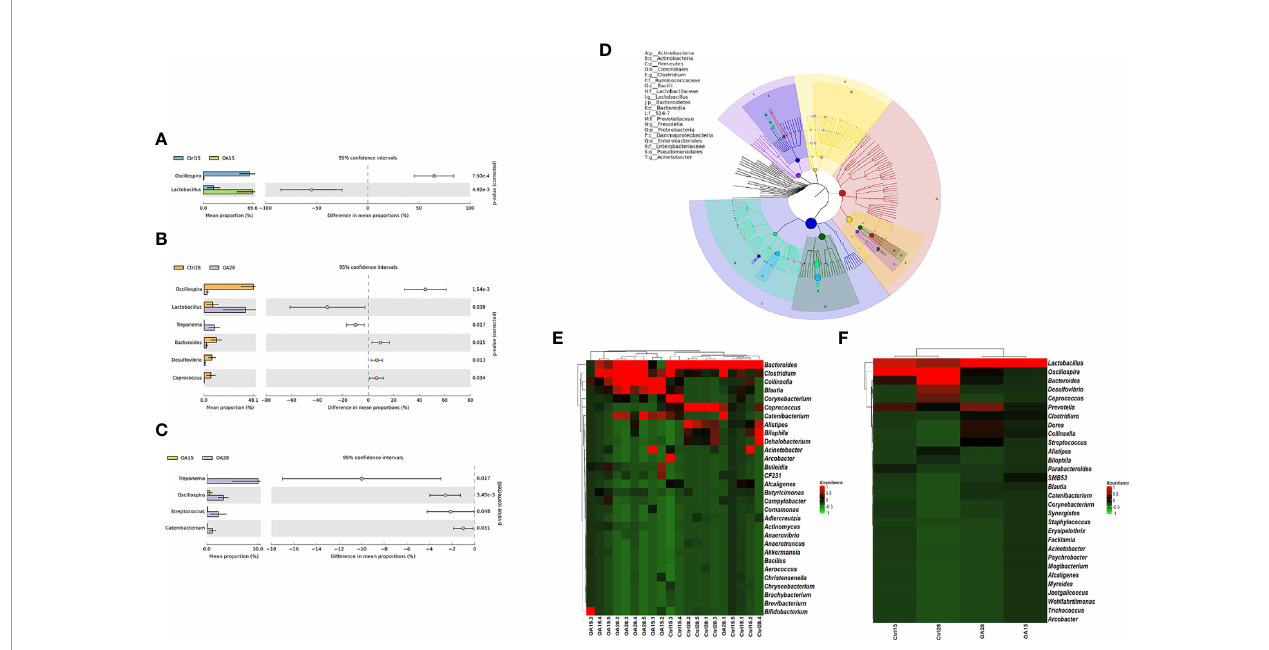
FIGURE 7 | Based on the OTU relative abundance of each sample, the differences of bacterial abundances among the Ctrl15 group, Ctrl28 group, and the fi rst feeding groups OA15 and OA28 were analyzed by using STAMP software with two-sided Student ’ s t-test. Ctrl15 group vs. OA15 group (A) , Ctrl28 group vs. OA28 group (B) , OA15 group vs. OA28 group (C) . GraPhlAn tools were used for visualization of the hierarchical tree (D) . The hierarchical tree shows the hierarchical relationship of all taxons (represented by nodes) from phylum to genus (arranged from inner circle to outer circle in turn), and the node size corresponds to the average relative abundance of the taxon. The top 20 taxons of relative abundance will also be identi fi ed by letters in the fi gure (arranged from phylum to genus in order from outer layer to inner layer). The top 30 taxons of genus abundance were taken to analyze the differences between each sample (E) and each group (F) by heat maps which were drawn by R software (version 3.6.1) with the ggplot2 package.